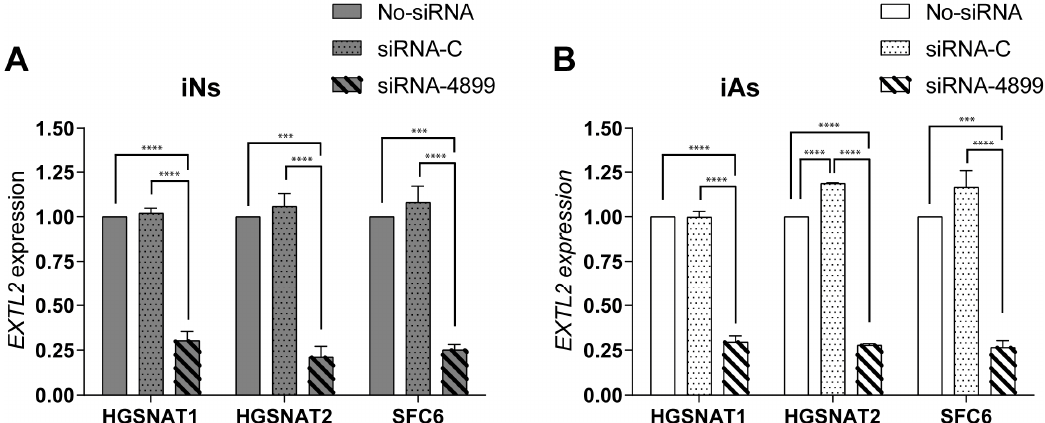
Figure 6. EXTL2 mRNA expression after siRNA treatment in iNs ( A ) and iAs ( B ) derived from three different HGSNAT -mutated cell lines: HGSNAT1, HGSNAT2, and SFC6. Expression of EXTL2 mRNA was normalized to GAPDH and relative to transfection with no-siRNA. Data are shown as mean ± s.e.m. from three independent experiments with two technical replicates. **** p value < 0.0001, *** p value < 0.001, ordinary one-way ANOVA corrected by Tukey post hoc test, comparing all three groups between each other within each cell line.